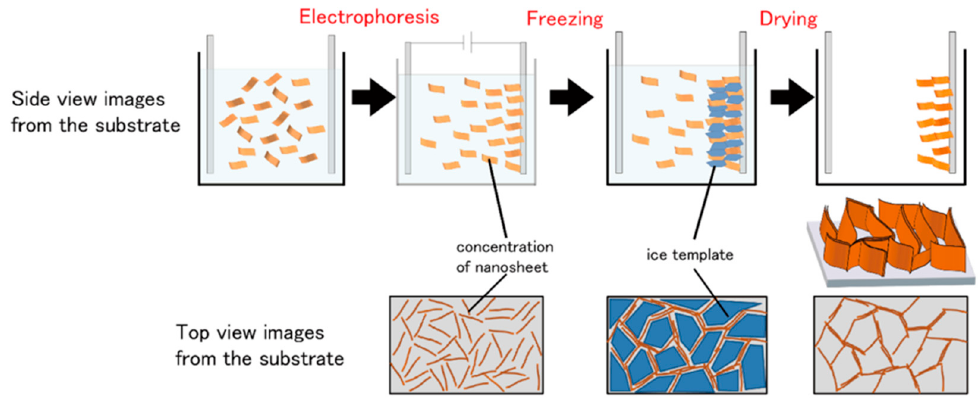
Figure 8. Vertically aligned film fabricated by electrophoresis and freeze drying for electrochemical capacitors. Reproduced with permission from ref. [107]. Copyright 2019, ACS Publications.